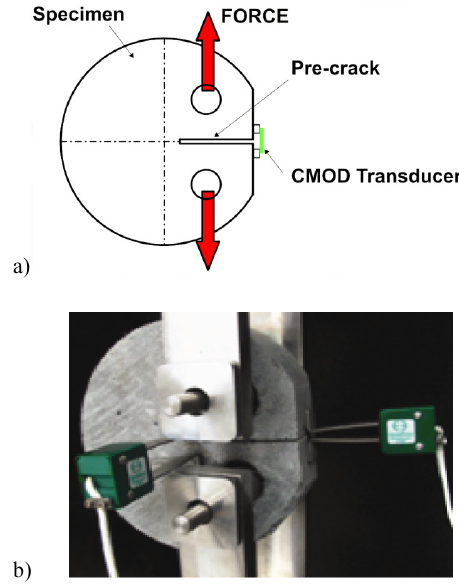
Fig. 3. Semi-Circular Bending test (SCB): a) SCB schematic; b) SCB Picture